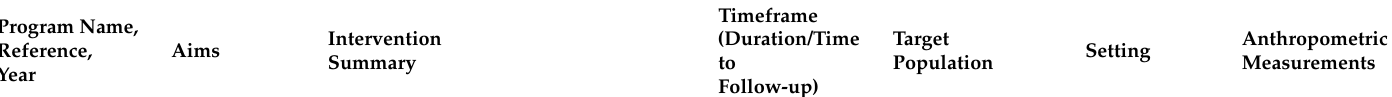
Table 2. Program characteristics for published literature ( n =